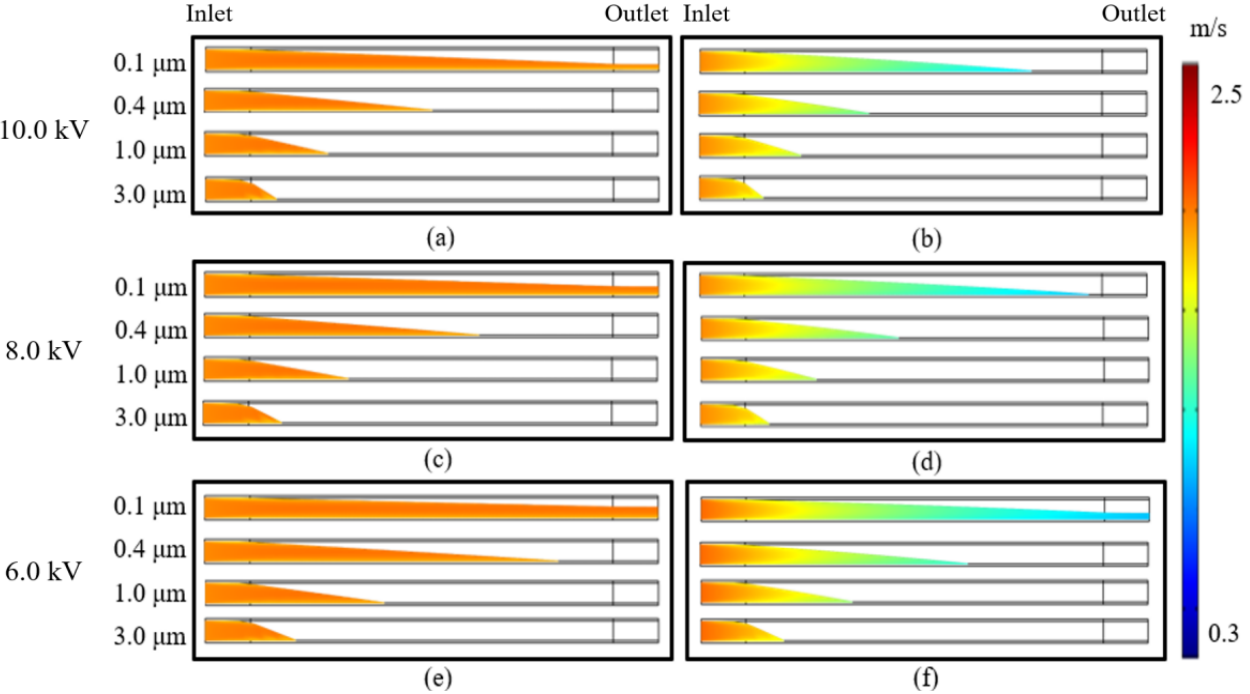
Figure 6. Movement of particles in the electric channels of the two types of micro-electrostatic filters under different dust-collection plate voltages: ( a , c , e ) show the particle movement of the combined plate-type micro-electrostatic filter at 10.0 kV, 8.0 kV, and 6.0 kV; ( b , d , f ) show the particle movement of the cylindrical micro-electrostatic filter at 10.0 kV, 8.0 kV, and 6.0 kV.